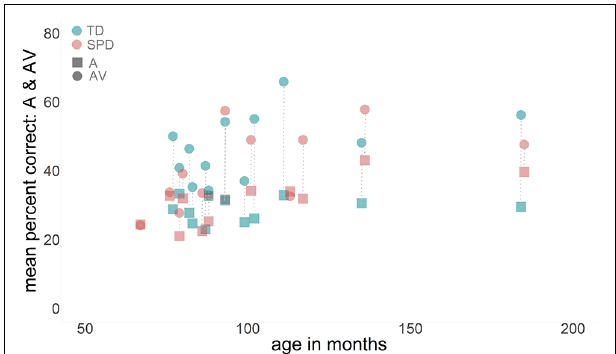
FIGURE 2 | Data are displayed as a function of age (x-axis), with auditory-alone performance represented by square symbols and audiovisual performance represented by the circle symbols. Dotted lines join each participants’ two data points together. There was no significant effect of age on audiovisual